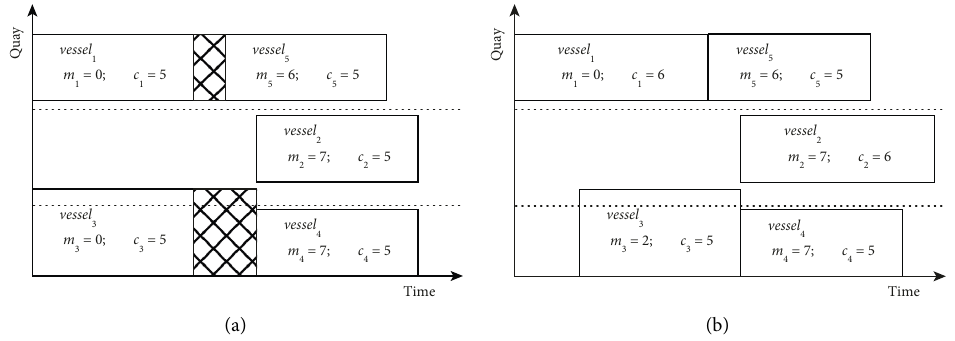
Figure 3: Example of baseline schedule with buffer times. (a) Baseline schedule where buffer time had been defined for vessels 1 and 3. Solution makespan � 12. (b) Current schedule at t � 13 where the handling time of vessels 1 and 2 is lengthened one time unit and vessel 3 is delayed two time units. Solution makespan �